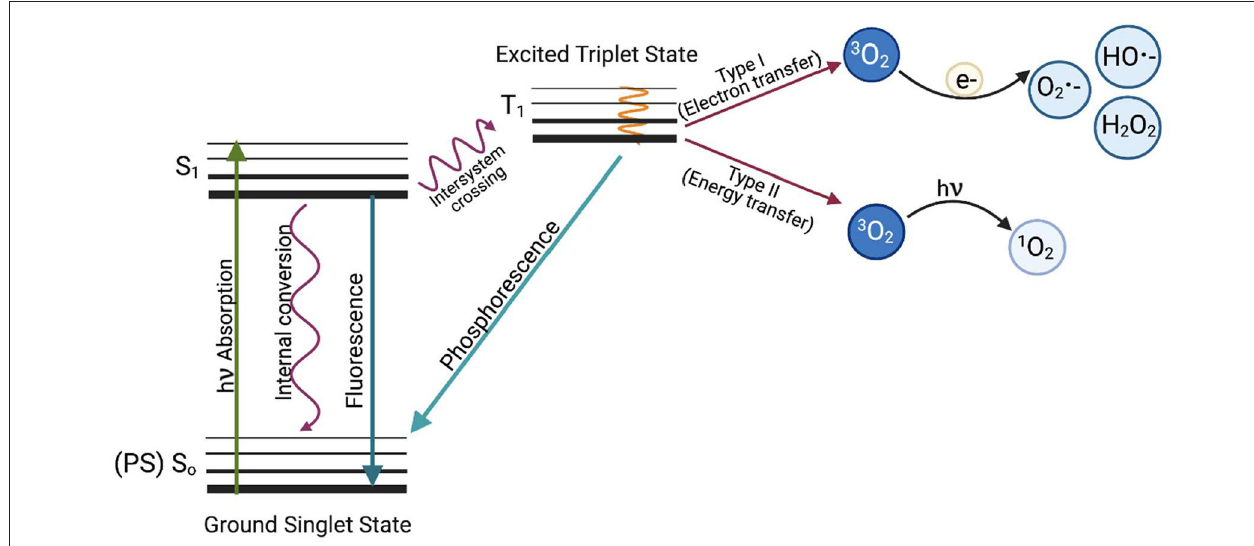
FIGURE 1 | The Jabło ´ nski diagram illustrates the mechanism of photodynamic inactivation. aPDI can be divided into two types of reactions. The type I (electron transfer) reaction occurs when a photon is absorbed by the PS, which causes PS excitation and transition from the ground PS singlet state (So) to the excited PS singlet state (S 1 ) and later to the excited triplet state via the inter-system crossing (T 1 ). When excited, the photosensitizer can transfer an electron (e − ) to molecular oxygen ( 3 O 2 ) to produce oxygen radicals and other reactive oxygen species such as superoxide anion (O 2 •− ), hydroxyl radical (HO •− ) or hydrogen peroxide (H 2 O 2 ) or can react with biomolecules such as membrane lipids. The first stage of the Type II reaction (energy transfer) is similar, but the photosensitizer in the triplet excited